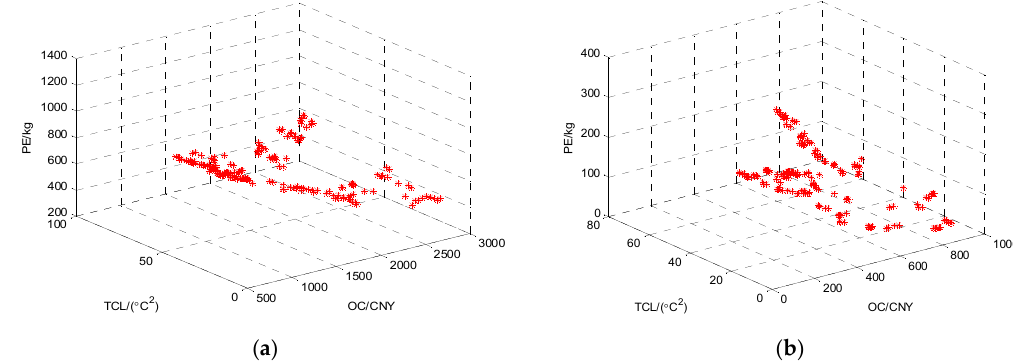
Figure 6. Pareto front of optimal scheduling for RR-microgrid with RFHCS. ( a ) A typical day in winter; and ( b ) a typical day in summer.